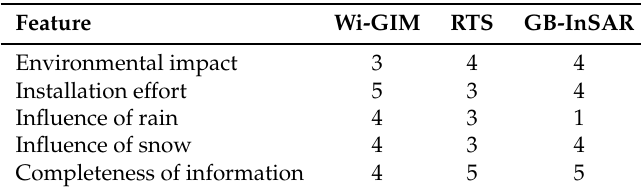
Table 7. Wi-GIM system benefits analysis compared to RTS and